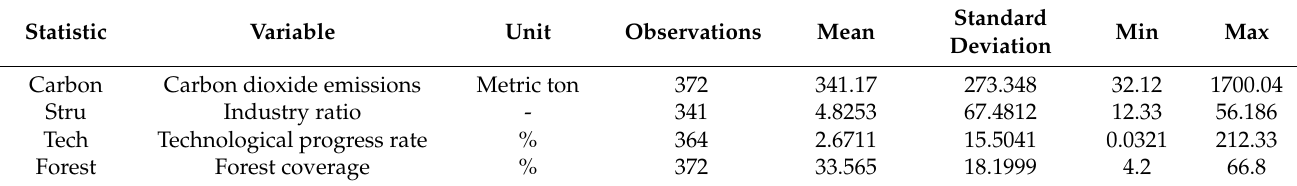
Table 6. Descriptive statistics of mediating